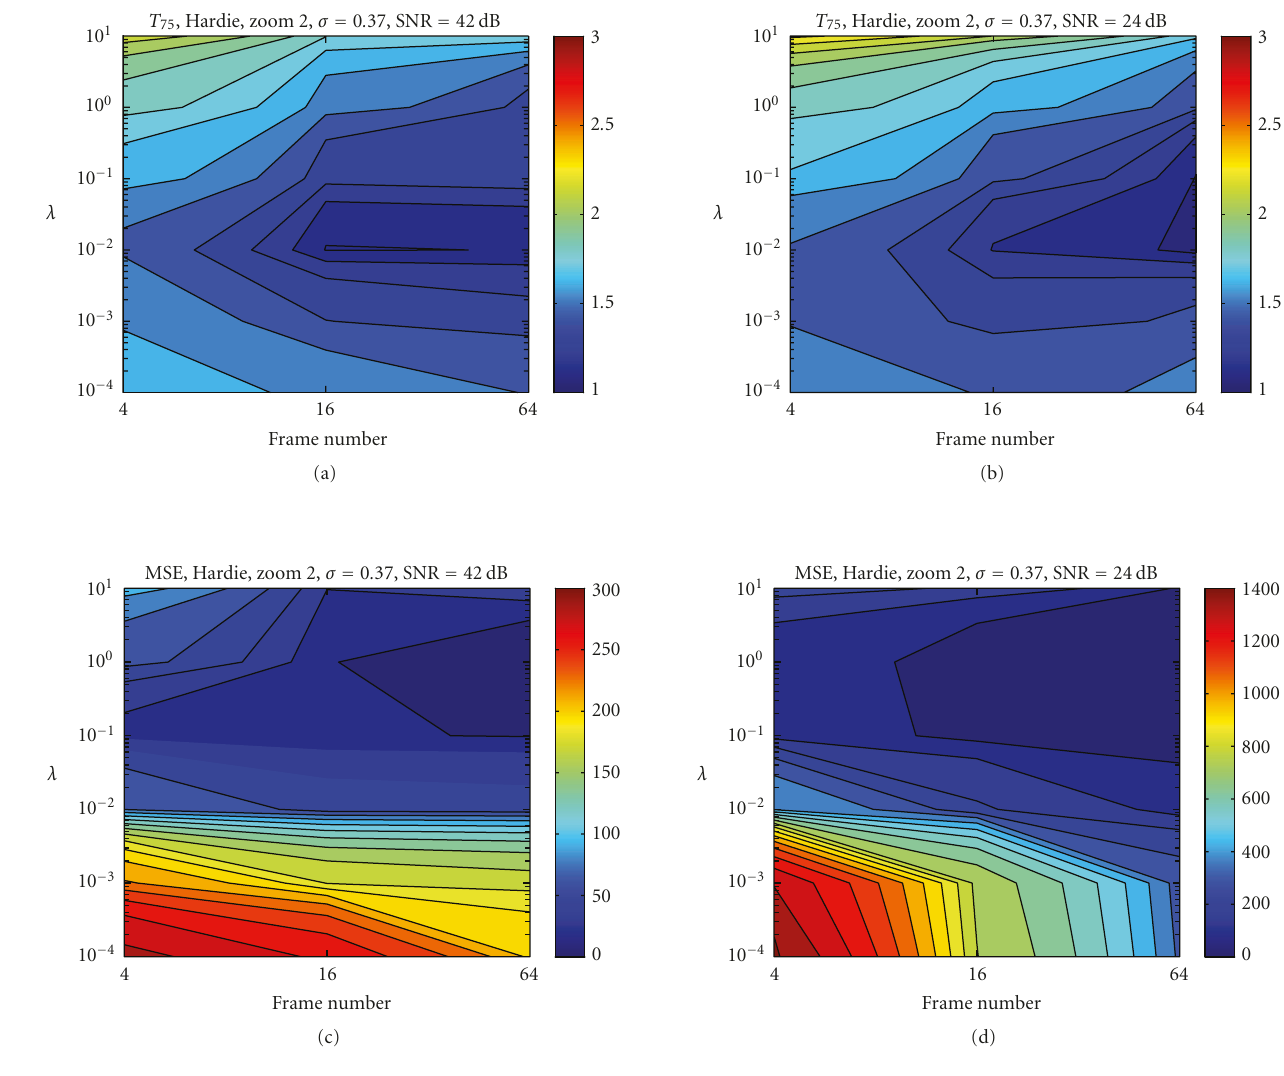
Figure 7: (a) Contour plot T 75 , SNR = 42dB, (b) contour plot T 75 , SNR = 24dB, (c) contour plot MSE, SNR = 42 dB, (d) contour plot MSE, SNR = 24